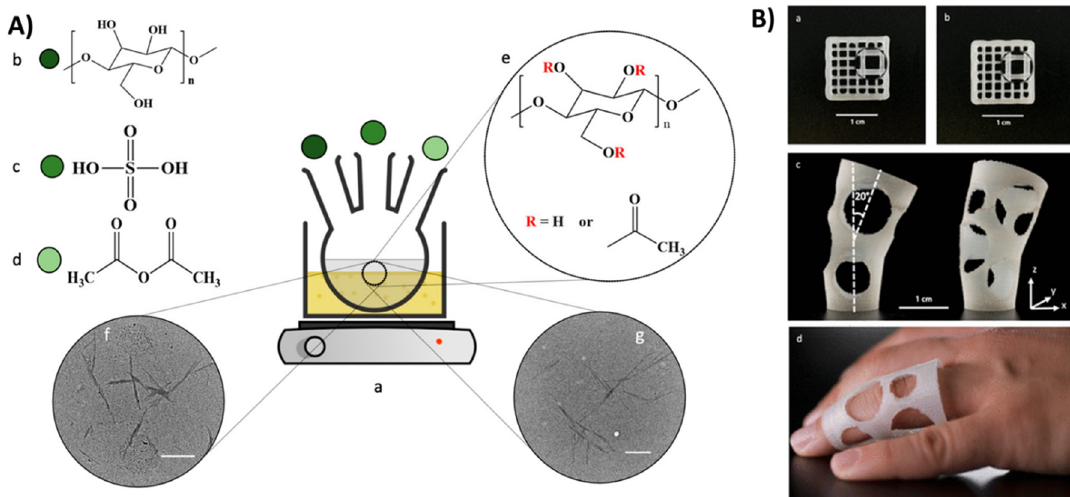
Figure 5. Illustration of CNC acetylation process and 3D-printed nanocellulose–PHBH-based composites showing the ( A ) acetylation process ( a ) of a CNC particle of a cellulose structure ( b ) by sulphuric acid ( c ) and acetic anhydride ( d ), and acetylated nanocellulose after functionalization ( e – g ). ( B ) FDM 3D-printed nanocellulose composites of PHBH-acetylated CNC (10%) showing an alteration of 0–90 ◦ ( a – c ) as an example of a medical device for finger dislocation ( c , d ), used with permission from ref.